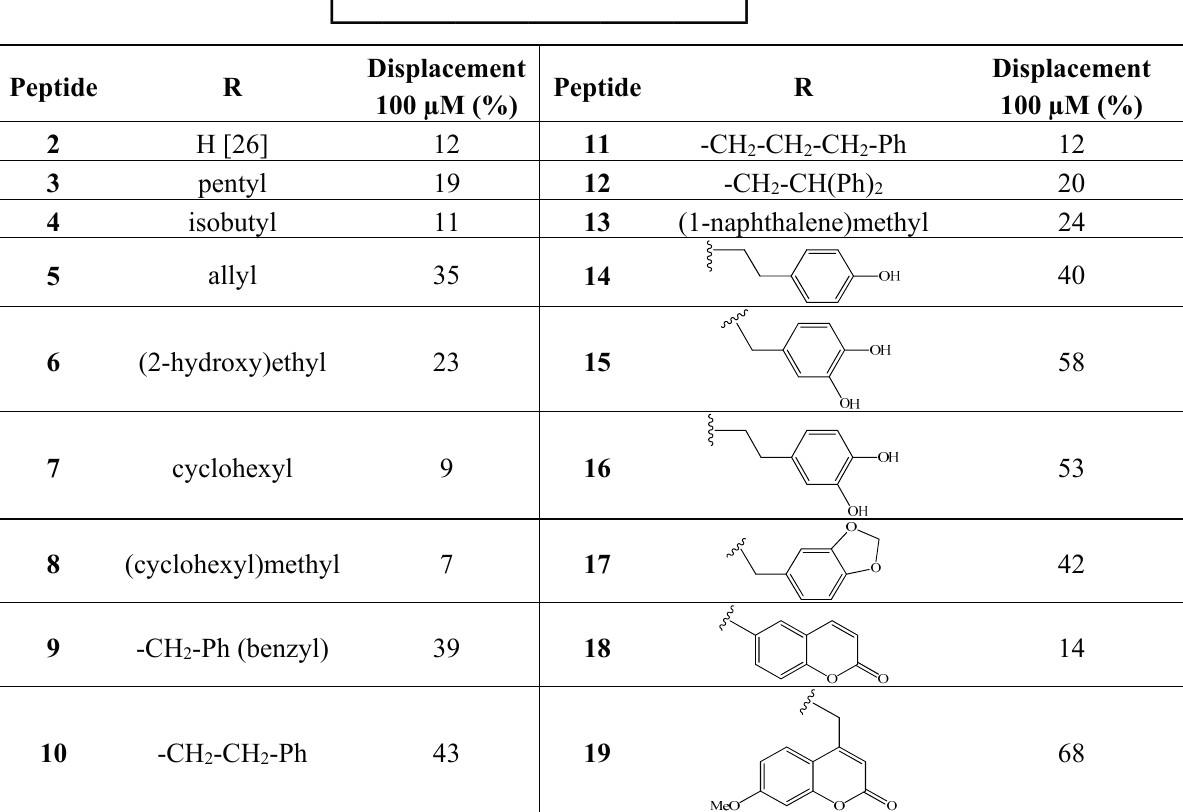
Table 1. Cyclic peptides with C-terminal substitutions. Displacement represents the percentage of btVEGF displaced by the peptides at 100 µM. The values are the average of at least 3 tests each in